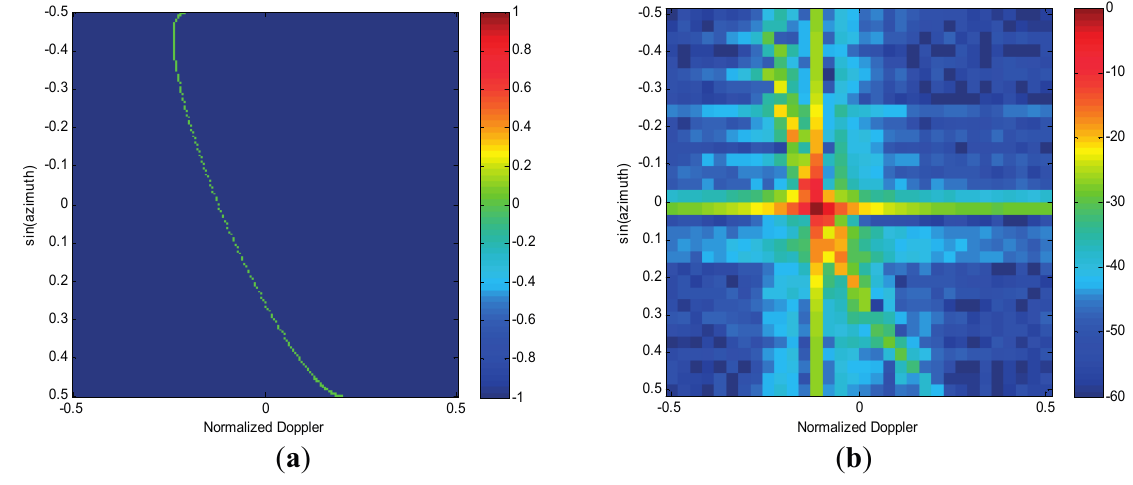
Figure 2. Angle-Doppler spectrum image of clutter. ( a ) Clutter trace. ( b ) 2D fast Fourier transform